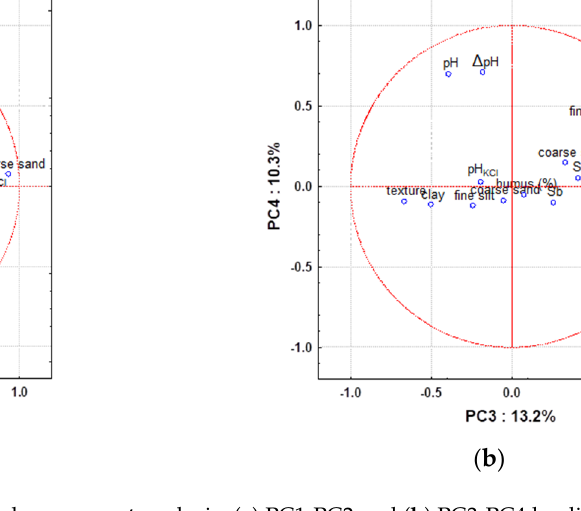
Figure 3. Principal component analysis: ( a ) PC1-PC2 and ( b ) PC3-PC4 loading